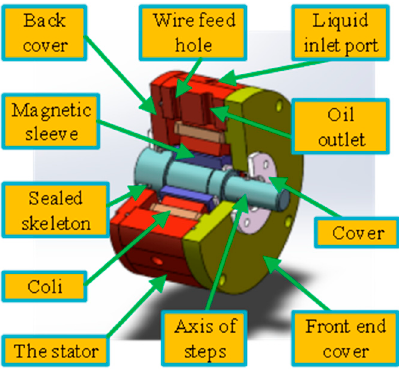
Figure 2. Magnetic fluid bearing semi-section equiaxial side diagram.